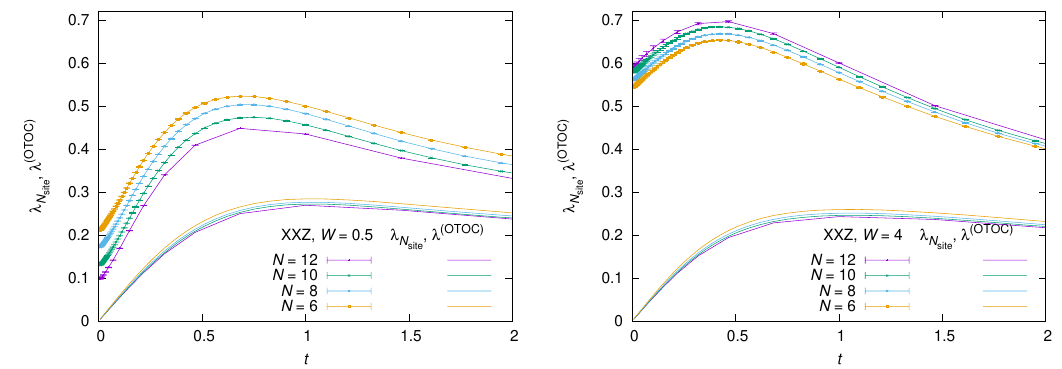
Figure 13 . (cid:21) N (with data points and error bars) and (cid:21) (OTOC) (with the same color as (cid:21) N site but data points omitted) at T = 1 plotted against time t for the XXZ model with N site = 12, [left] W = 0 : 5 (215 samples for N site = 12, more samples for N (cid:20) 10) and [right] W = 4 (at least 102 samples for N site = 12, more samples for N (cid:20)